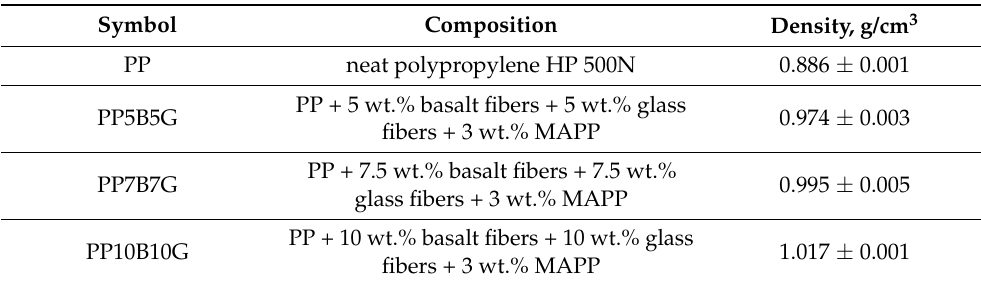
Table 2. The density and composition content of composites. Symbol